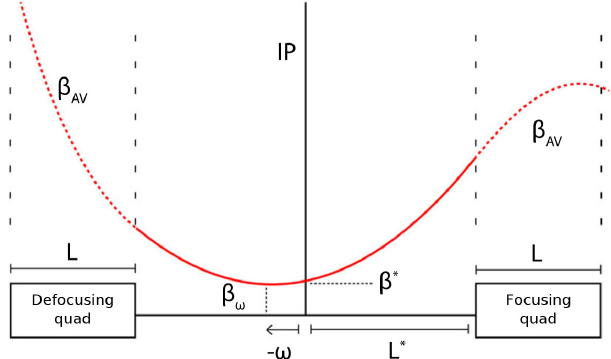
FIG. 1. Illustration of an interaction region and optics function